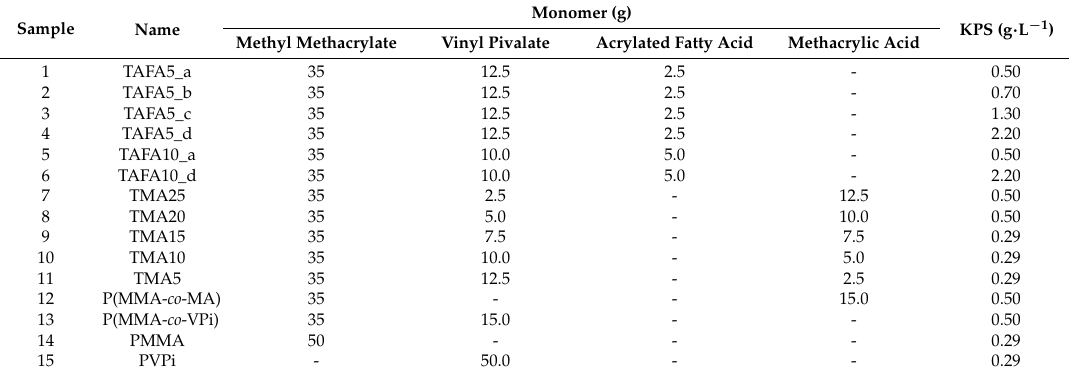
Table 1. Sample names and the respective amounts of monomers and initiator used for polymerization.